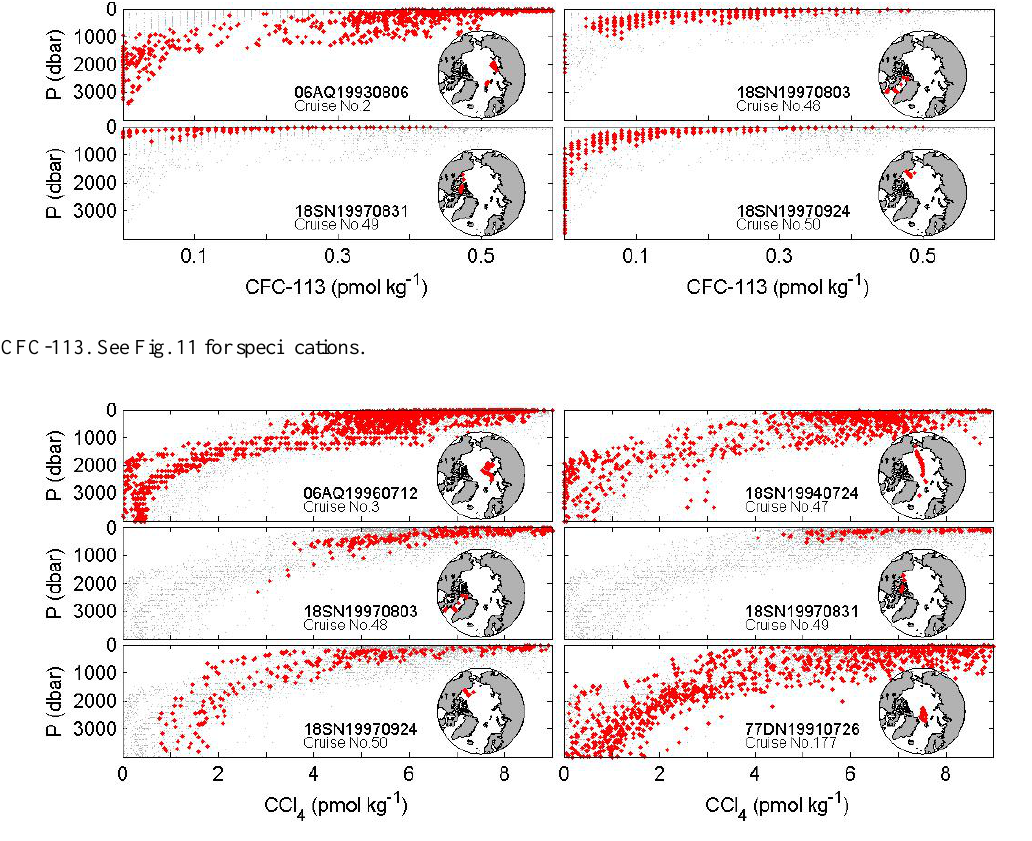
Figure 14. CCl 4 . See Fig. 11 for